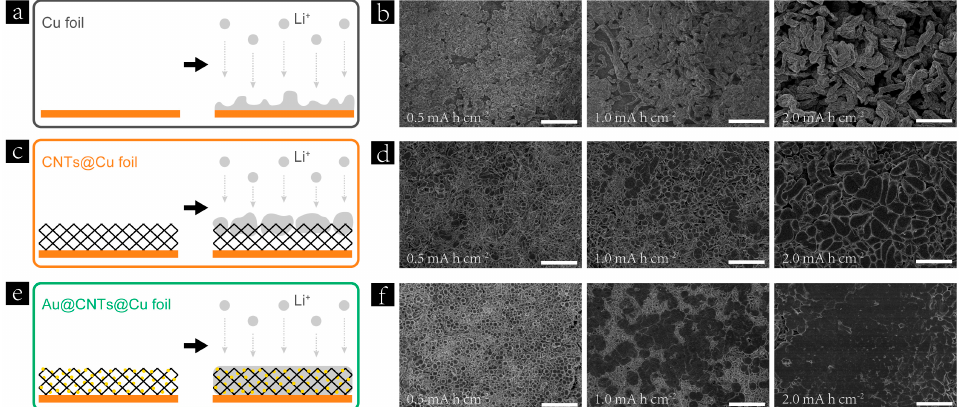
Figure 4. Schematic illustration of Li nucleation and deposition on ( a ) Cu foil, ( c ) CNTs@Cu foil, and ( e ) Au@CNTs@Cu foil. Top-view SEM images of ( b ) Cu foil, ( d ) CNTs@Cu foil, and ( f ) Au@CNTs@Cu foil after plating gradually increased areal capacities of 0.5, 1.0, and 2.0 mA h cm − 2 at a current density of 1 mA cm − 2 . All scale bars are 25 μ m.